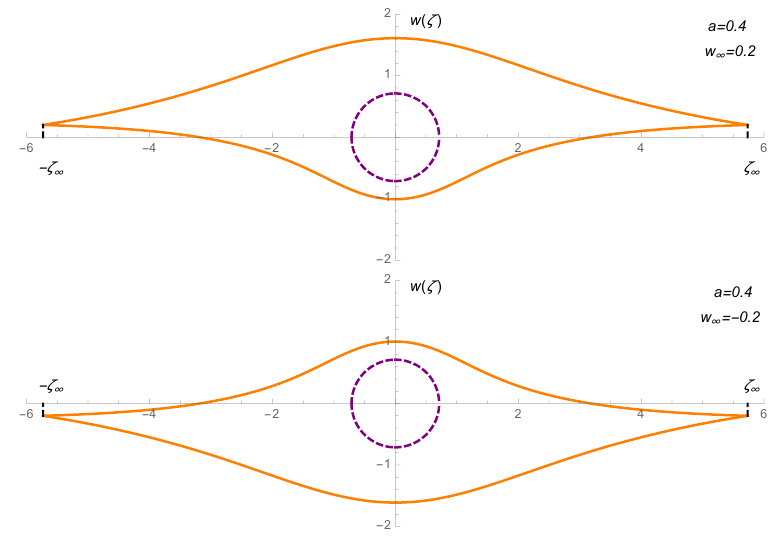
Figure 9 . The massive case of the embedding flavor branes with fixed a . Upper: the positive mass case with w ∞ = 0 . 2 . Lower: the negative mass case with w ∞ = − 0 . 2